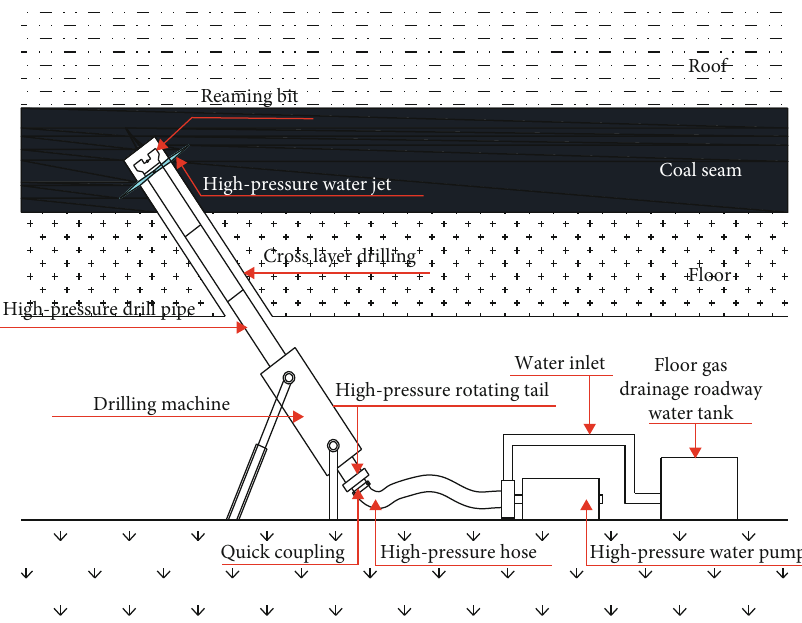
Figure 7: Diagram of the layout of the device on site.